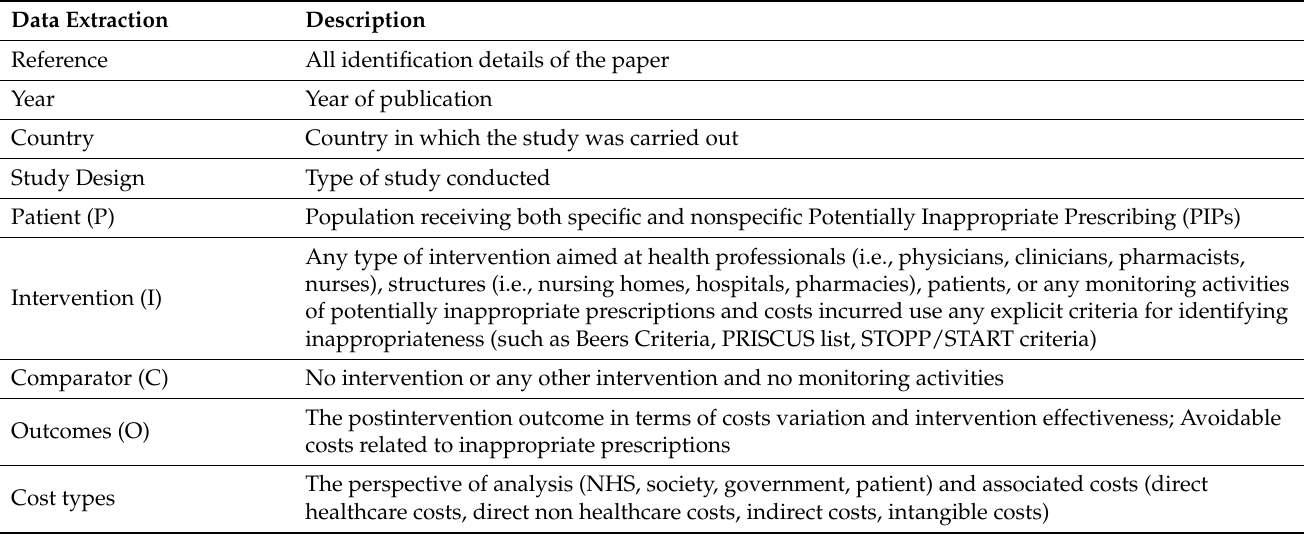
Table 2. Data extraction and analysis process: PICO